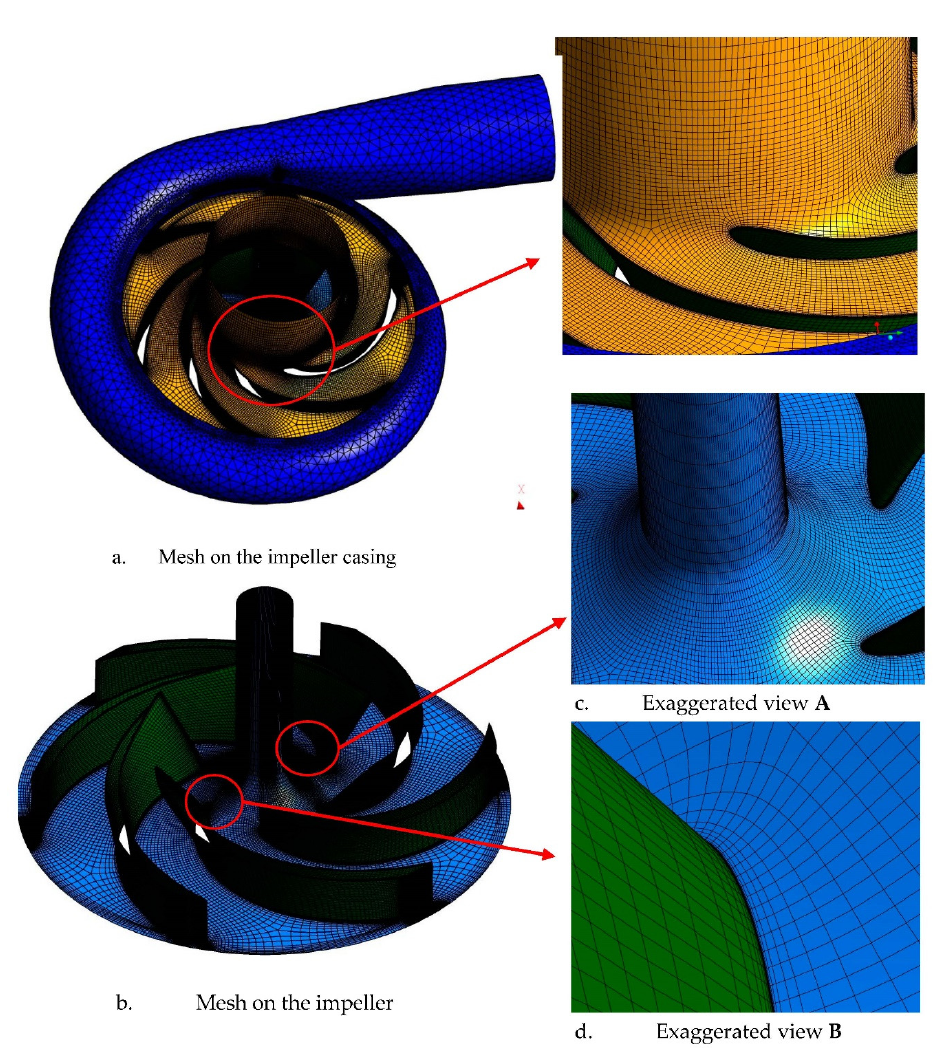
Figure 2. Mesh for rotating and stationary domains.